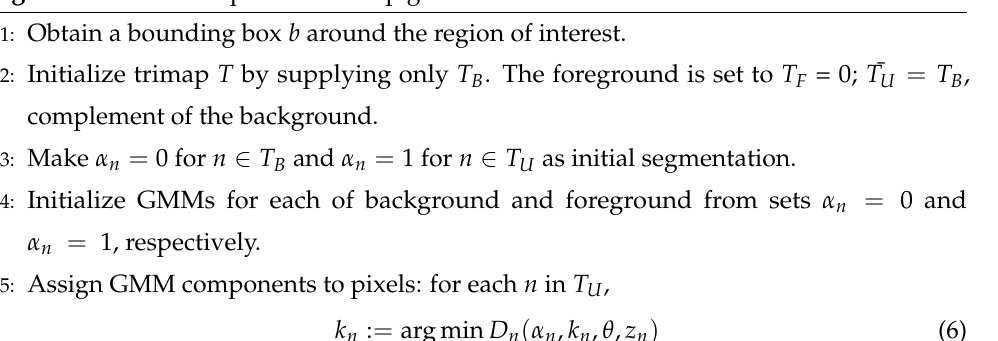
Algorithm 1 GrabCut pixel-level map